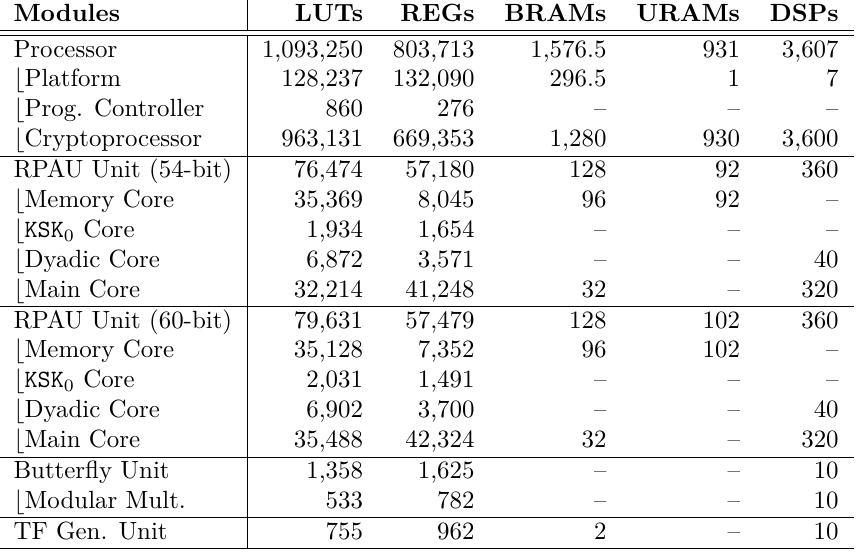
Table 3: Resource Utilization of Arithmetic Modules on Alveo U250